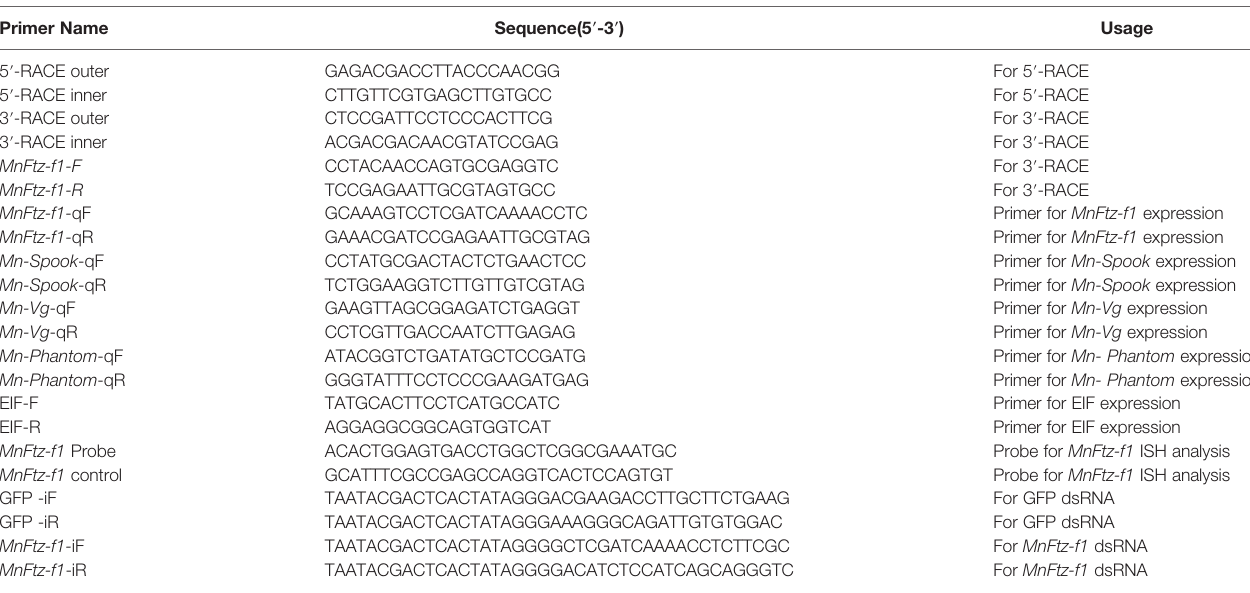
TABLE 1 | Primers used in this